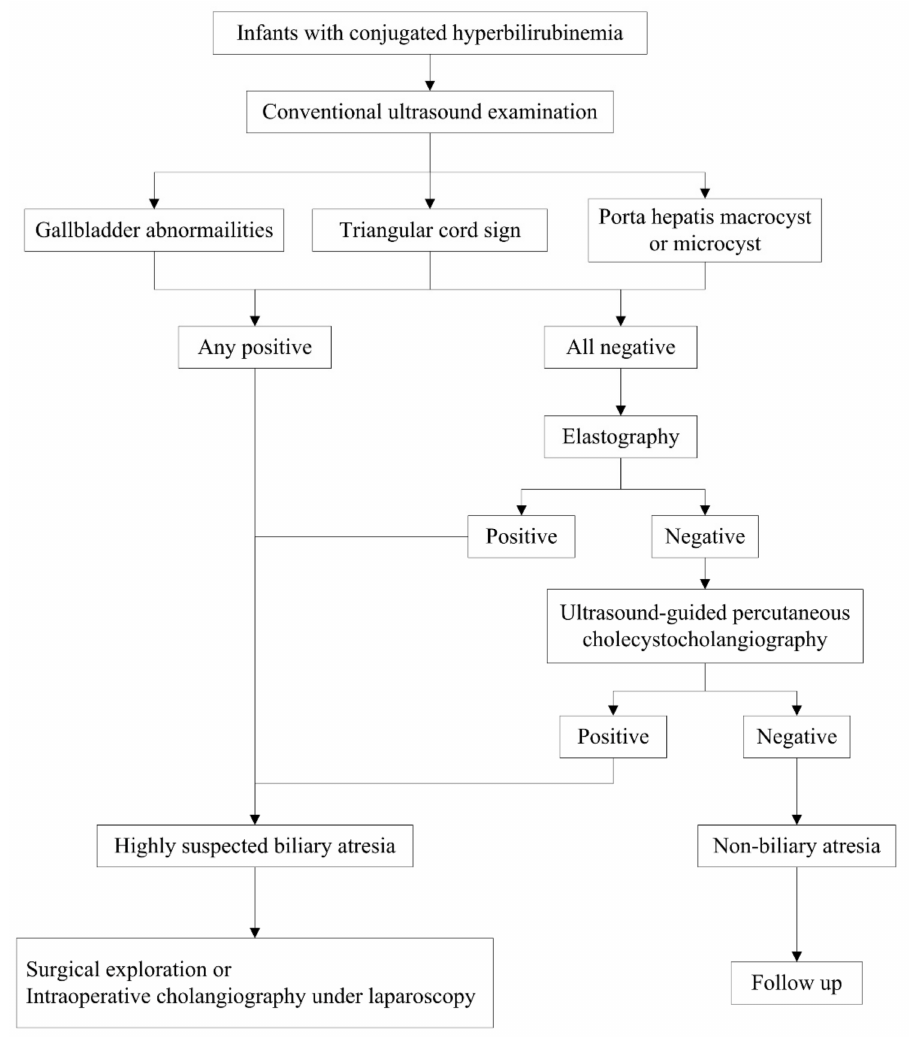
Figure 9. Diagnostic flowchart of biliary